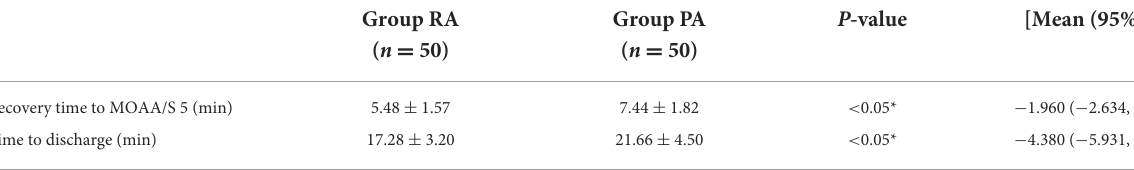
TABLE 4 Comparison of time for recovery and time to discharge between the two groups.